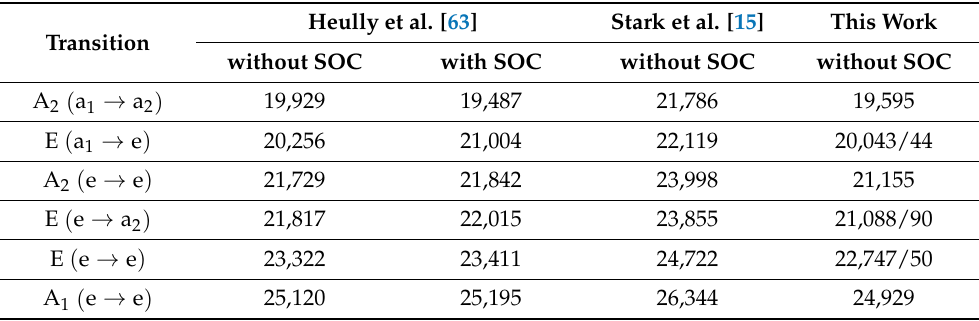
Table 3. Wavenumbers (in cm − 1 ) for vertical MLCT transitions in RBY calculated by the TDDFT method. Heully et al. [63] Stark et al. [15] This Work Transition without